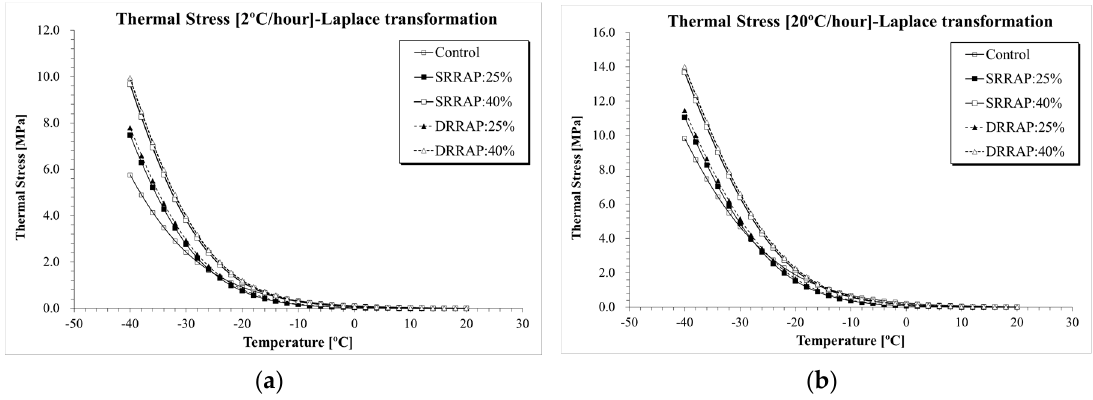
Figure 8. σ ( T ) computation results (Hopkins and Hamming, 1957): ( a ) 2 °C/h; ( b ) 20 °C/h.